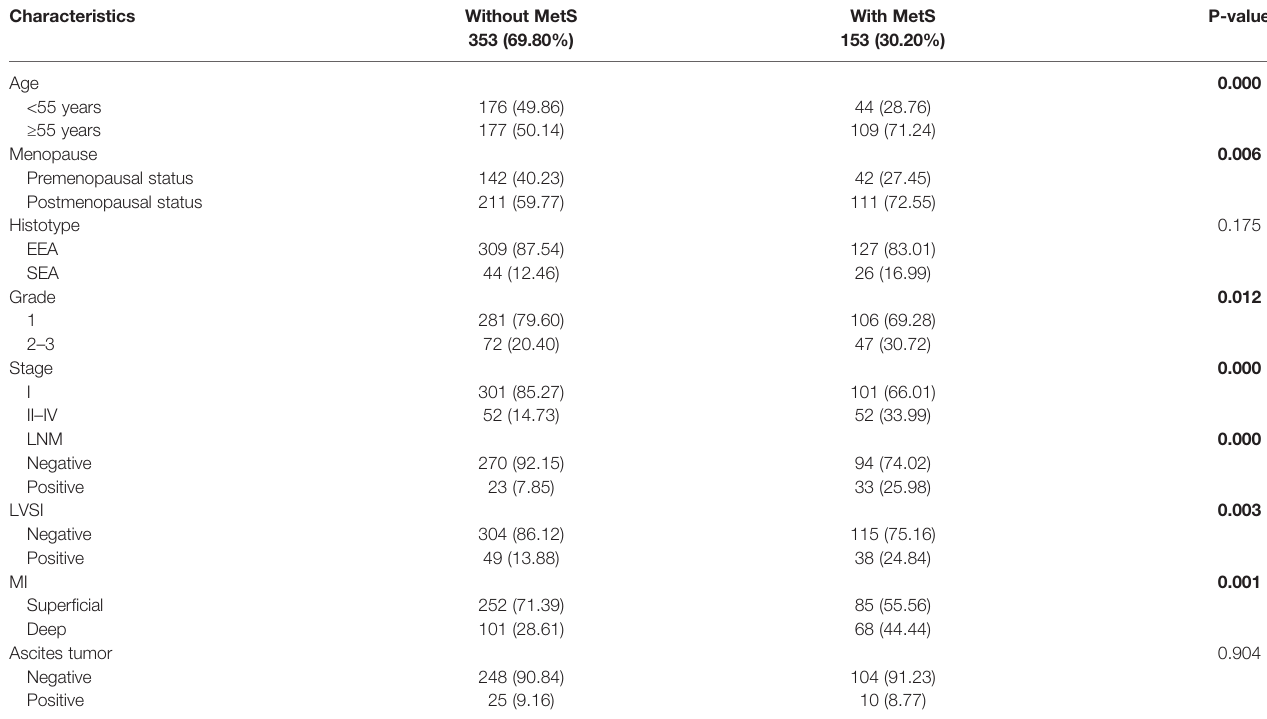
TABLE 2 | MetS associated with clinicopathological characteristics of EC patients. Characteristics Without